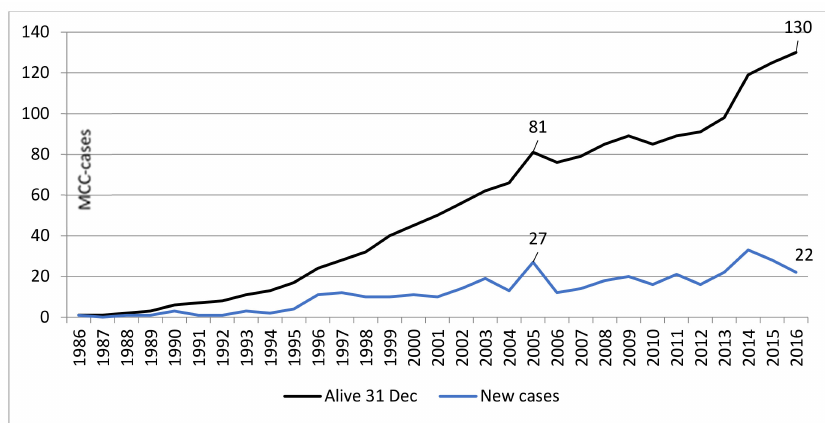
Figure 1. Annual incidence and prevalence of MCC in 1986–2016 in Finland. Table 1. Demographic data of the 376 MCC patients treated in Finland in